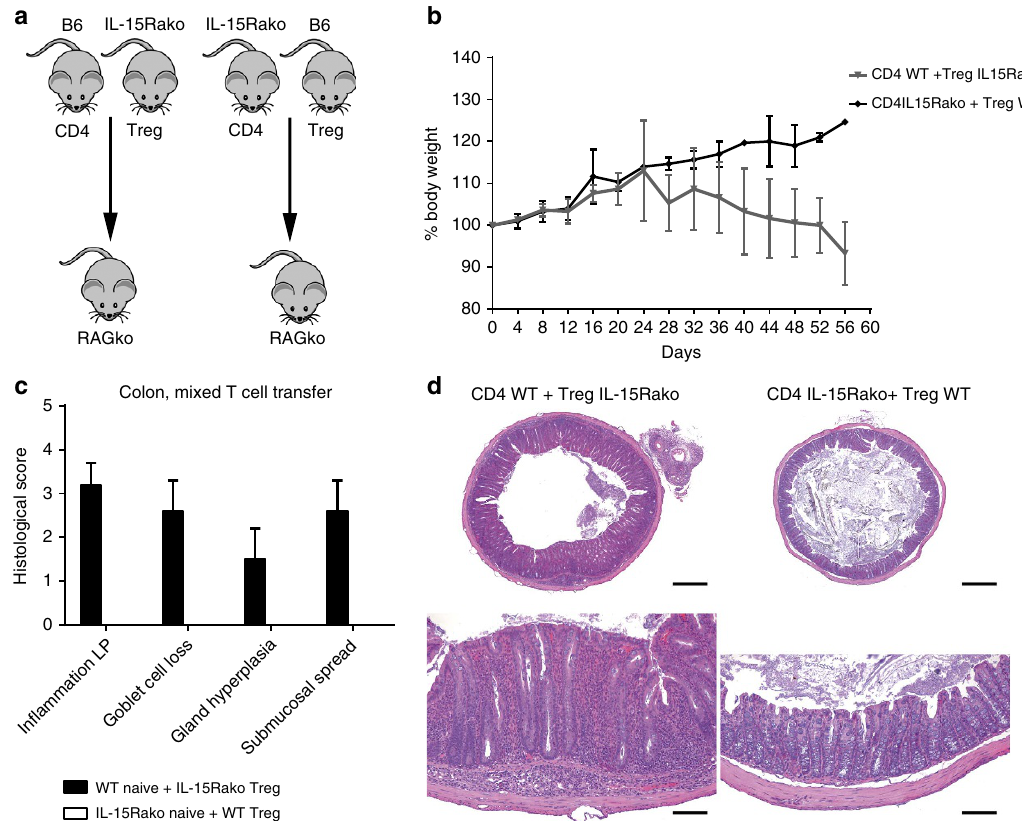
Figure 5 | Treg with impaired IL-15 signaling fail to prevent colitis in RAG2ko hosts injected with both Treg and naive CD4 þ T cells. ( a ) Treg (CD4 þ Foxp3 þ ROR g t (cid:2) ) and naive CD4 þ T lymphocytes (CD4 þ Foxp3-CD62L hi CD45RB hi ) were sorted from Foxp3-mRFP (cid:3) ROR g t–GFP and from IL-15R a ko (cid:3) Foxp3-mRFP (cid:3) ROR g t–GFP mice. About 10 5 IL-15R a ko Treg cells were injected together with 10 5 IL-15-competent naive CD4 þ T cells into RAG2ko mice. Similarly, 10 5 IL-15R a ko naive CD4 þ were injected together with 10 5 IL-15-competent Treg cells into other group of RAG2ko mice. Recipient mice were killed 8 weeks later. ( b ) Body weight curve of recipient RAG2ko, which received IL-15R a ko Treg and WT CD4 þ Tcells (grey line) and of RAG2ko mice injected with IL-15R a ko CD4 þ and WT Treg cells (black line). ( c ) Histological scores (from 0—minimal to 5—severe) of microscopic changes in the colon of RAG2ko mice following transfer of IL-15R a ko Treg and WT CD4 þ Tcells (black bars) and RAG2ko following transfer of IL-15R a ko CD4 þ and WT Treg cells (white bars). The score values for the second group are 0, therefore they are not visible 8 weeks post transfer. All graphs indicate mean values; error bars denote s.e.m. ( d ) Haematoxylin and eosin-stained sections of colons from RAG2ko mice after naive CD4 þ /Treg T-cell transfer. Original magnification: upper panel (cid:3) 4 (scale bar, 250 m m), bottom panel (cid:3) 10 (scale bar, 100 m m). ( a – d ) Data compiled from two separate experiments with at least three mice per